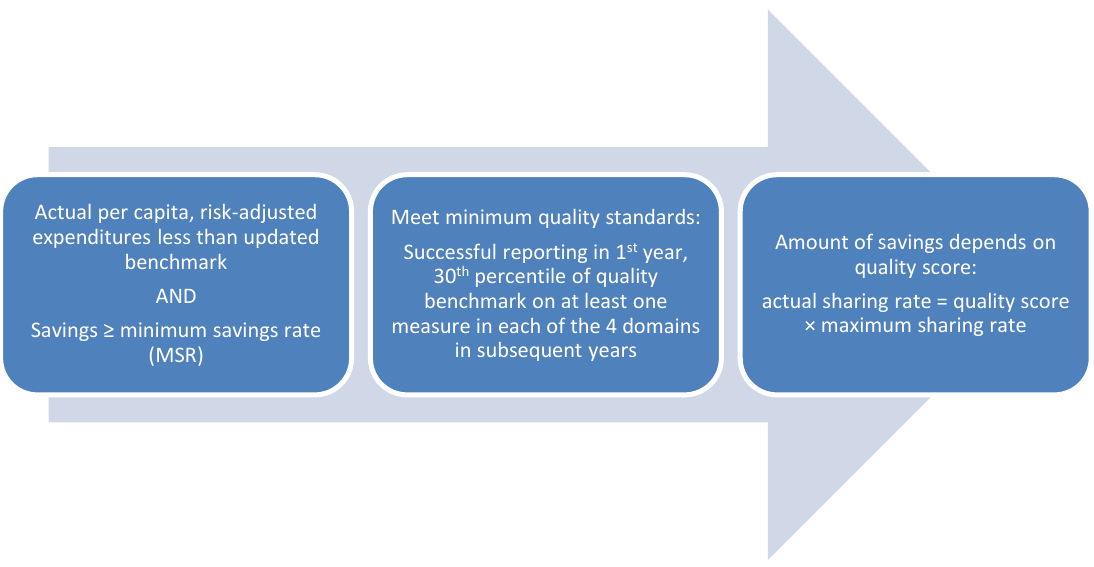
Figure 9.1: Determination of shared savings in the Medicare Shared Savings Program, track